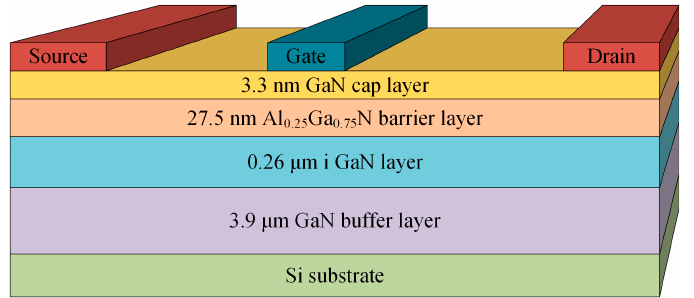
Figure 1. Device structure of AlGaN/GaN HEMTs.